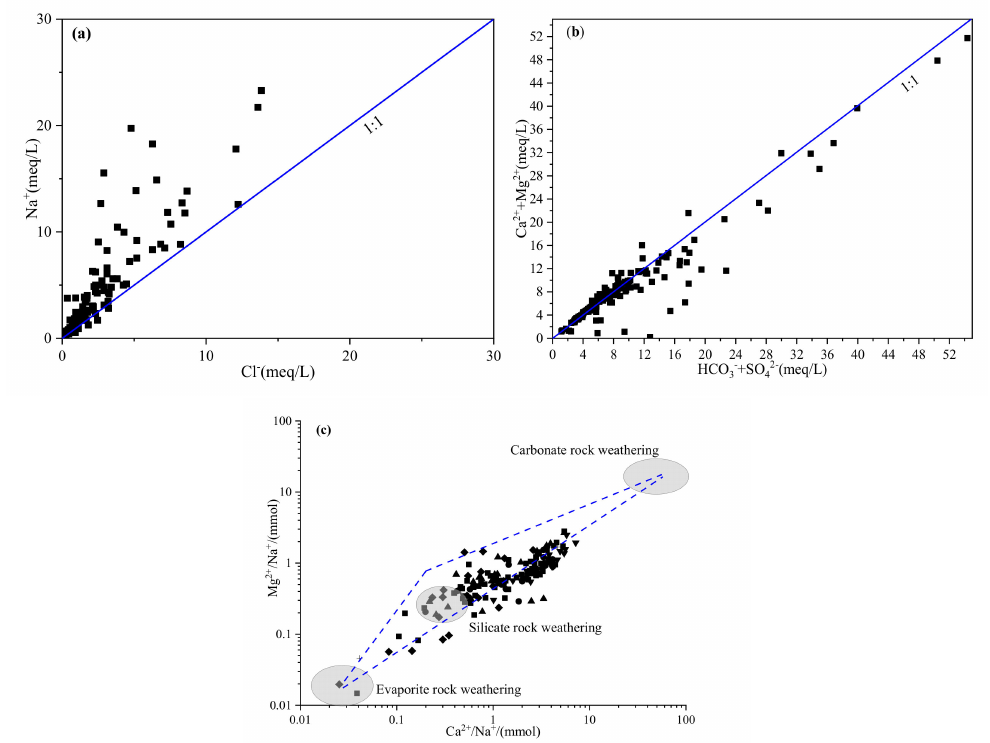
Figure 8. Ionic ratio plots of the major ions: ( a ) Cl − /Na + , ( b ) (Ca 2+ +Mg 2+ )/(HCO 3 − +SO 42 − ), ( c ) Ca 2+ /Na + VS Mg 2+ /Na +